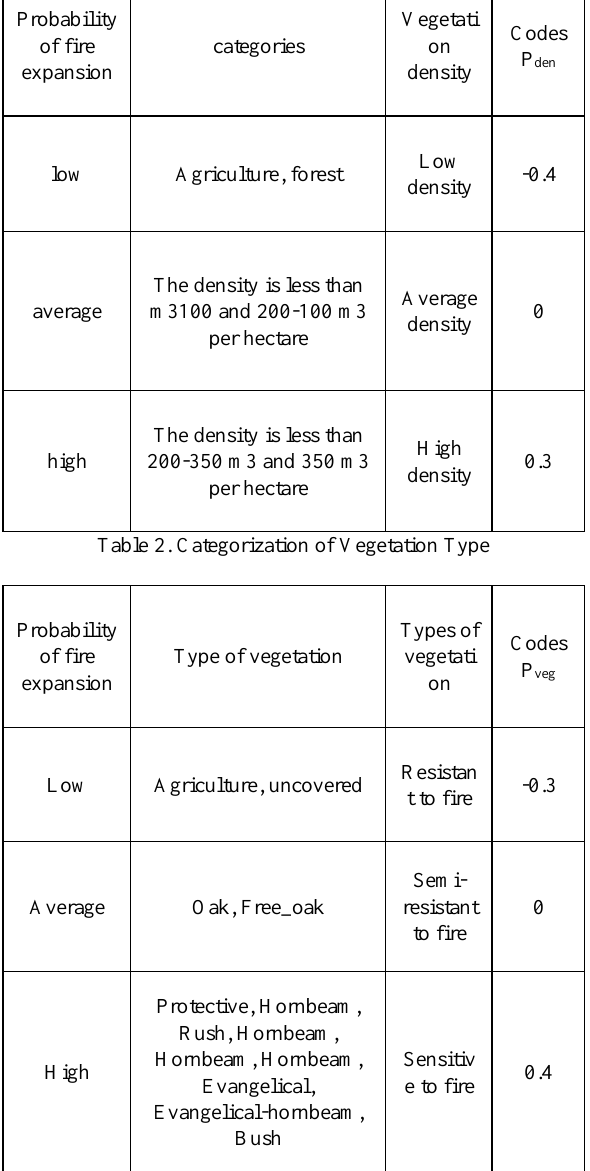
Table 3. Distribution of Vegetation Concentration